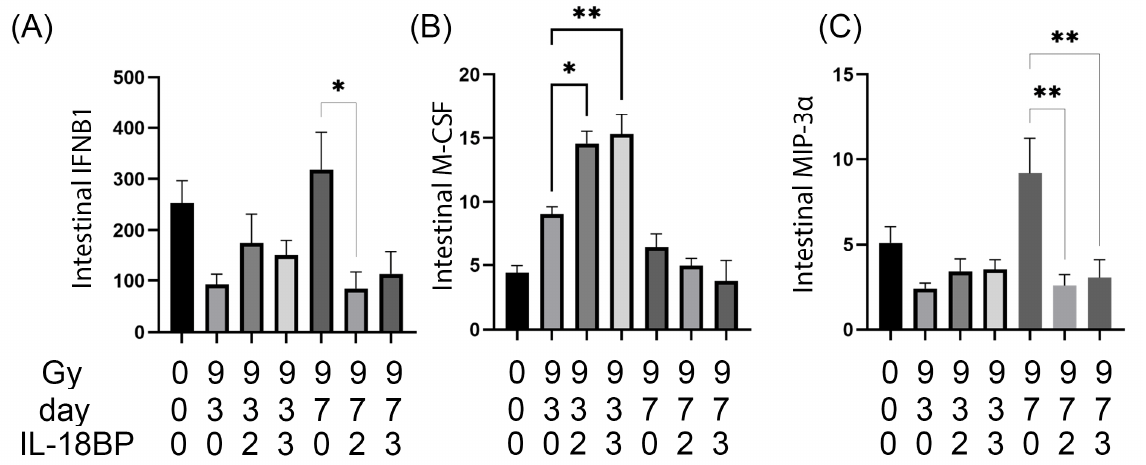
rhIL-18BP treatment significantly decreased 3 out of the 44 intestinal cytokines at either d3 or d7 post 9.0 Gy TBI, including IFNB1, M-CSF, and MIP-3 α (Figure 7). rhIL-18BP treatment significantly decreased levels of IFNB1 and MIP-3 α at d7 only (Figure 7A,C), but significantly increased the intestinal levels of M-CSF at d3 only (Figure 7B). Both 2 and 3 mg/kg rhIL-18BP treatment had significant effect on intestinal M-CSF and MIP-3 α levels (Figure 7B,C), while only 2 mg/kg rhIL-18BP treatment had significant effect on IFNB1 levels post TBI (Figure 7A).